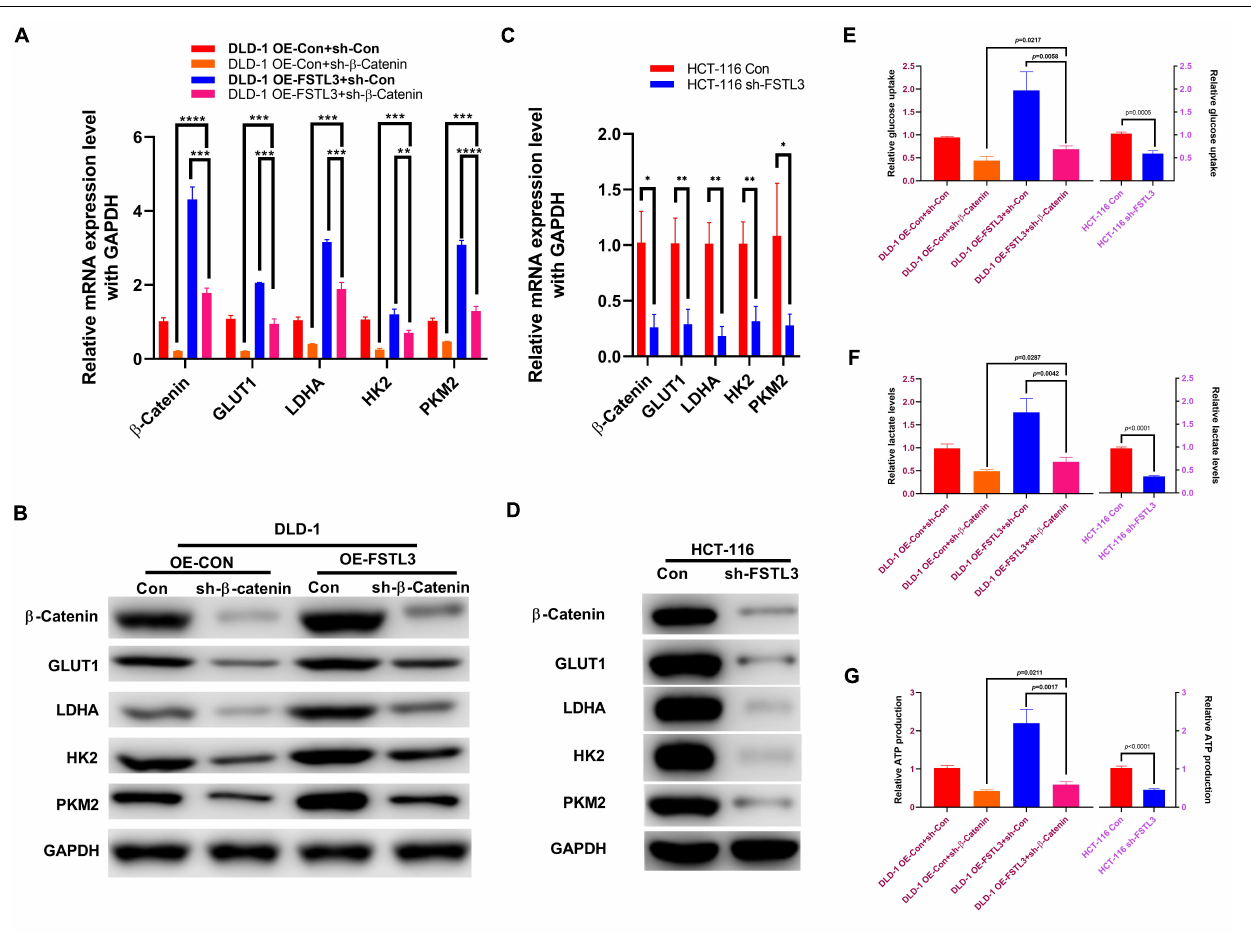
FIGURE 5 | FSTL3 induces β -Catenin-mediated glycolysis. (A,B) qRT-PCR and WB assays displayed increased mRNA and protein expression of GLUT1, LDHA, HK2 and PKM2 in FSTL3 overexpressed and/or sh- β -Catenin DLD-1 cells, compared to control. **** p < 0.0001; *** p < 0.001; ** p < 0.01. (C,D) qRT-PCR and WB assays displayed decreased mRNA and protein expression of GLUT1, LDHA, HK2 and PKM2 in HCT-116 sh-FSTL3 cells, compared to control. **p < 0.01; *p < 0.05. (E–G) Expression of FSTL3 and β -Catenin were significantly connected with glucose uptake, lactate levels and ATP production in DLD-1 cells, compared to control; knock-down FSTL3 significantly reduced glucose uptake, lactate levels and ATP production in HCT-116 cells, compared to